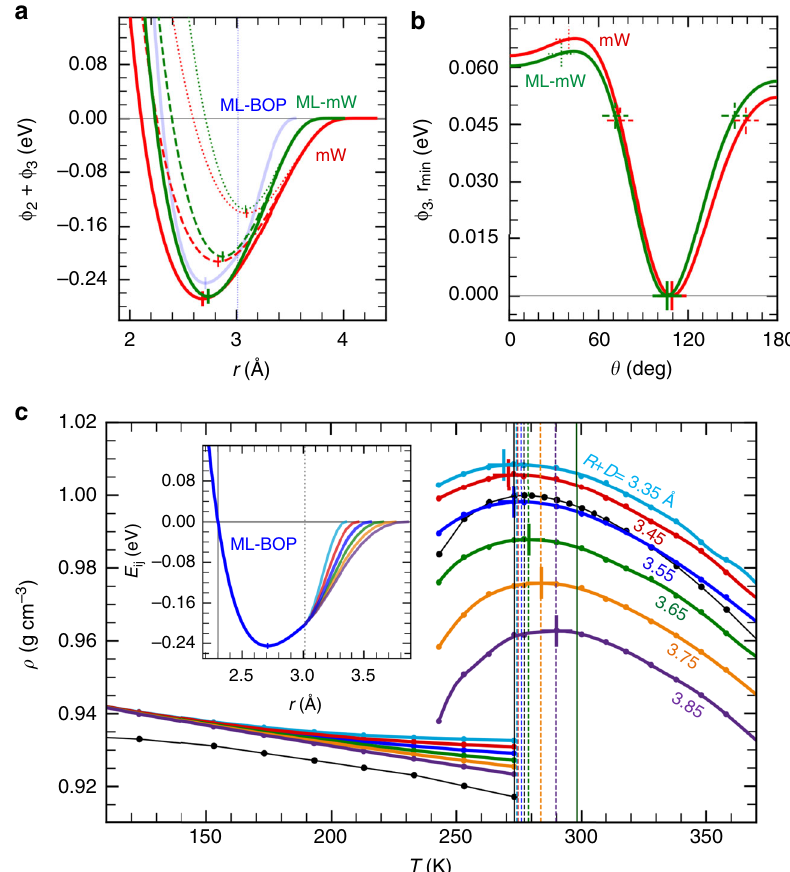
Fig. 3 Origin of the performance improvements in the ML-mW and ML-BOP models. a Solid line style curves compare the 2-body only interaction energy of ML-mW, mW, and ML-BOP ( ϕ 3 = 0 for the mW models and b ij = 1 for ML-BOP). The vertical dotted line marks the Tersoff cutoff switching distance ( R − D ) in ML-BOP. Dashed and dotted line style curves show the pair interaction energy of ML-mW and mW under the in fl uence of a third atom, the addition of ϕ 3 . b 3-body energy term, ϕ 3 , evaluated at the minimum of the pair interaction energy curves, r min . Note that we fi rst identify r min for each interatomic angle θ and then compute the corresponding ϕ 3. The cross marks indicate the θ at which the interaction energy curves in ( a ) are evaluated. c The explicit cutoff function, f c , in Tersoff provides a fl exibility to independently modify the tail portion of the pair interaction energy curve (inset). This in fl uences the relative separation between melting point (cross marks) and TMD (vertical dotted lines) in the temperature-dependent density